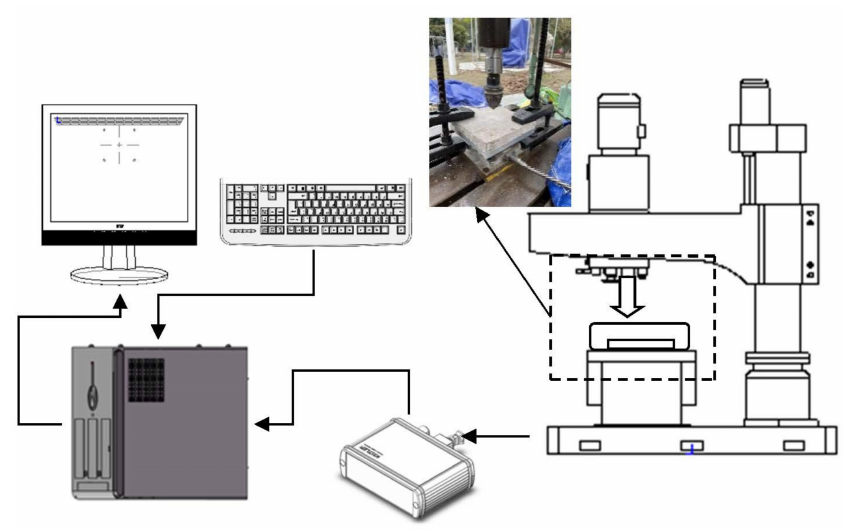
Figure 8. Schematic of the experimental